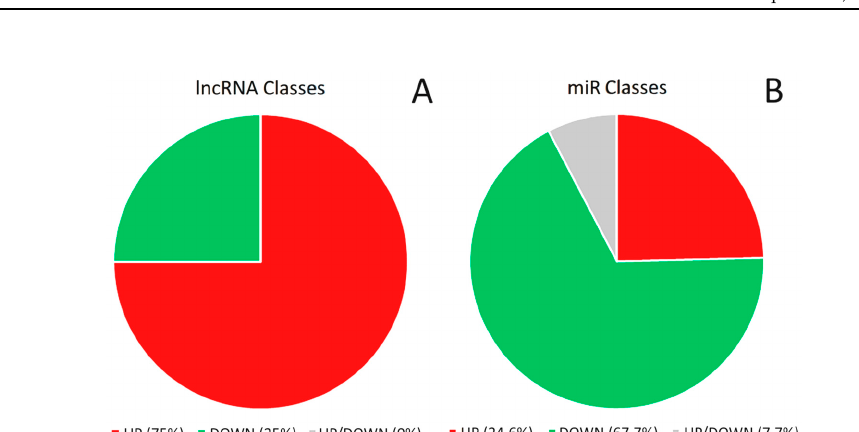
Figure 1. Classification of long non-coding RNA (lncRNA) and micro-RNA (miR) involved in bladder cancer (BC) etiology based on their regulation. ( A ) lncRNA classes according to their levels of expression in BC vs. normal urothelium. lncRNA are divided into two classes: (i) lncRNA that are up-regulated (in red; 24/32); and (ii) lncRNA that are down-regulated (in green; 8/32). To date, BC-related lncRNA have been univocally described as up- or downregulated. ( B ) miR classes according to their levels of expression in BC vs. normal urothelium. miR are split into three classes: (i) miR that are upregulated (in red; 16/65); (ii) miR that are downregulated (in green; 44/65); and (iii) miR that have been described both as up- and downregulated and, as such, cannot be univocally classified using the available data (in grey; 5/65). Notably, while 75% of the BC-related lncRNA are upregulated (i.e., they act as oncogenes), more than 70% of these miR are potentially downregulated (considering all